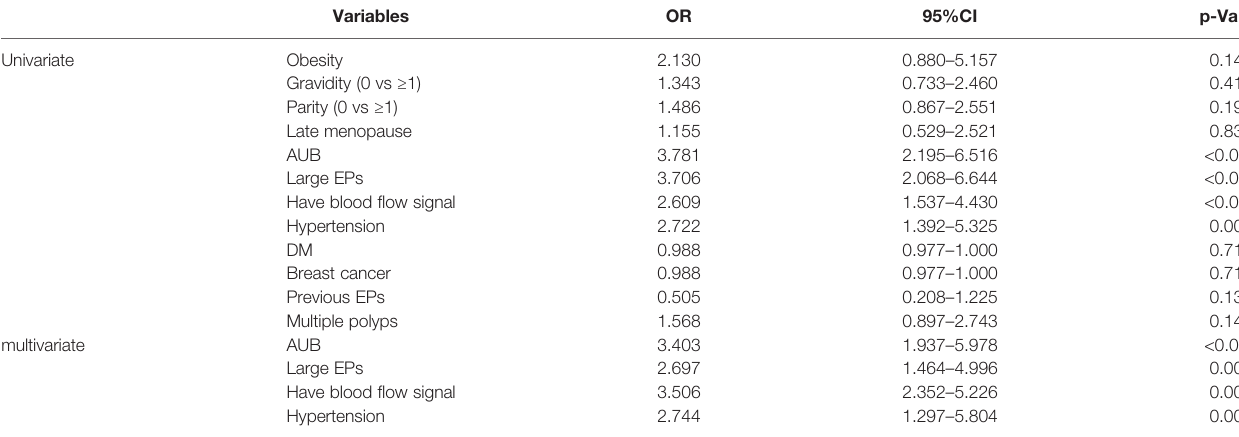
TABLE 5 | Univariate and multivariate analysis of demographic and clinical data between benign and malignancy groups in premenopausal patients in training set.